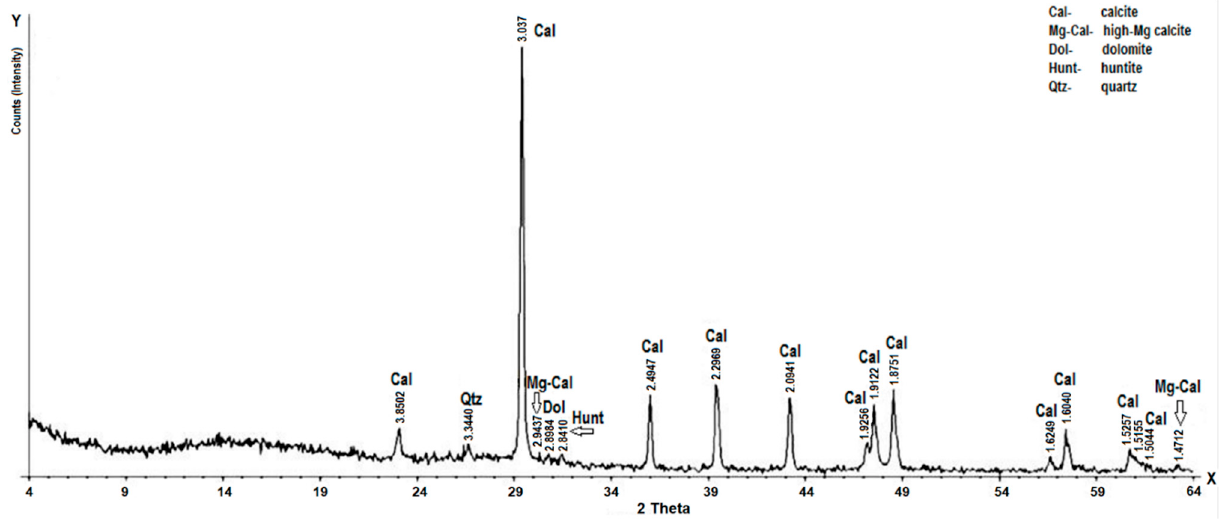
Minerals 2021 , 11 , x FOR PEER REVIEW Figure 2. Diffractogram of sample G2, limestone of Gogolin Unit taken in the Gogolin Quarry [24].